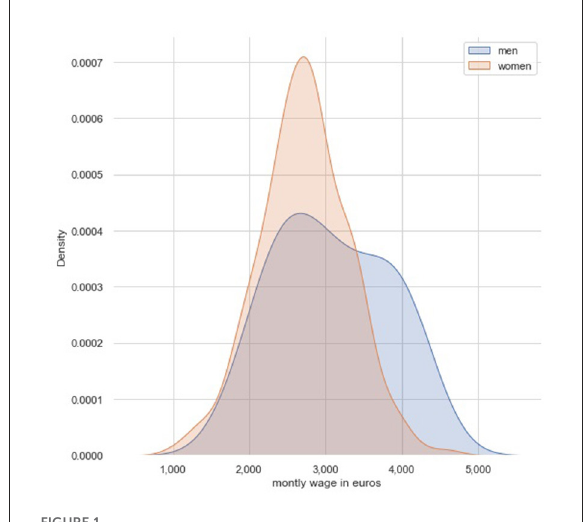
FIGURE3 Wage distribution according to